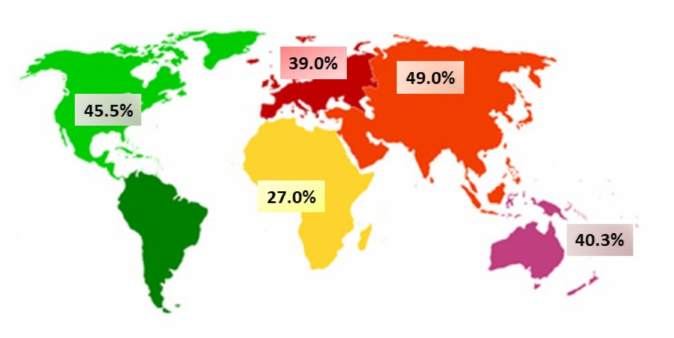
Figure 1. Lifetime low back pain prevalence in children and adolescent populations worldwide